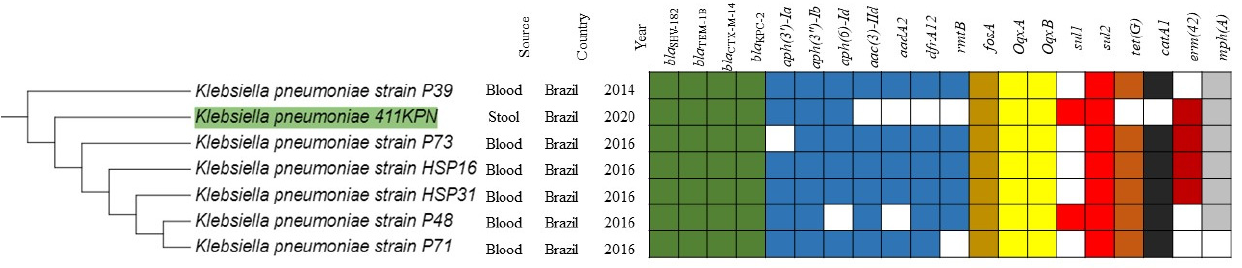
Figure 2. Heat map of the resistome of Klebsiella pneumoniae strains grouped in the phylogenetic analysis in the same cluster as the KP411